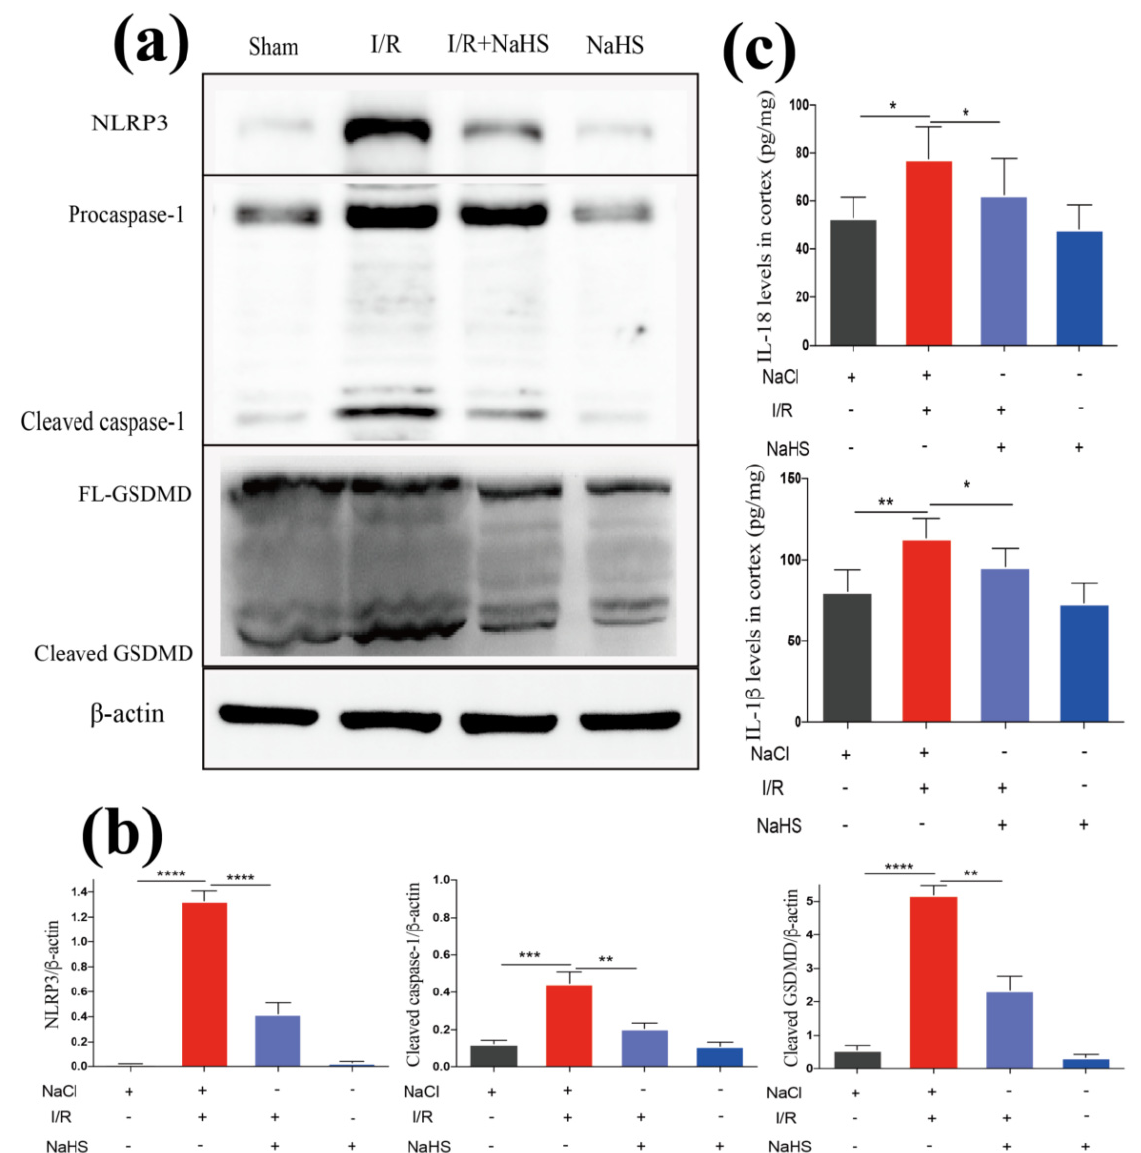
Figure 3. NaHS suppressed inflammasome-dependent pyroptosis in the rat brain cortex after I/R. ( c ) ELISA analysis of proinflammatory cytokines in the brain cortex from I/R rat ( n = 5). ( a ) Western blot analysis of NLRP3, caspase-1, and GSDMD in the brain cortex. ( b ) Quantitative analysis of expression levels of NLRP3, caspase-1, and GSDMD in the brain cortex ( n = 3). Data are represented as means ± SD, * p < 0.05, ** p < 0.01, *** p < 0.001, **** p < 0.0001.